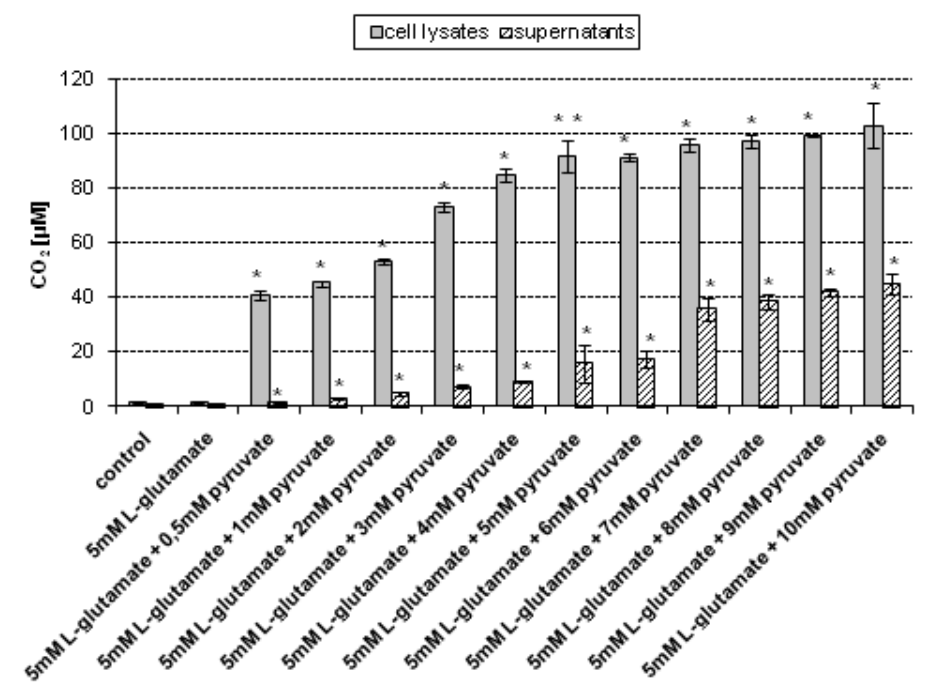
sodium L -glutamate. HT22 cells were incubated with 5 mM sodium L -glutamate for 24 h. After treatment, cells and superntants were separated. The cells were then lysed using a measurement sodium pyruvate was added (final concentations of lysis buffer. Prior to CO 2 sodium pyruvate: 0.5–10 mM, respectively) to the samples containing cell lysates and supernatants, respectively. The CO level was assessed using a stopped-flow 2